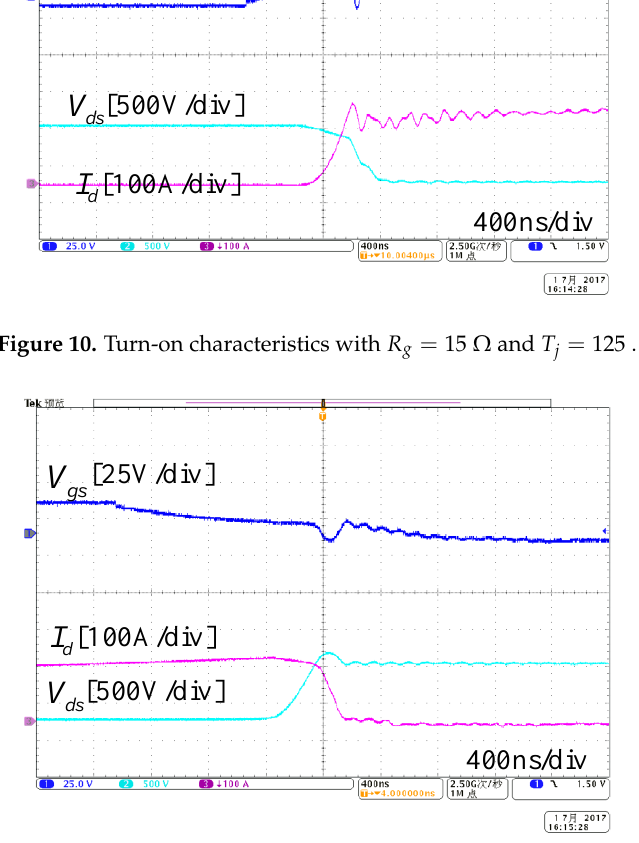
Figure 11. Turn-off characteristics with 𝑅 𝑔 = 15 Ω and 𝑇 𝑗 = 125 ℃ .